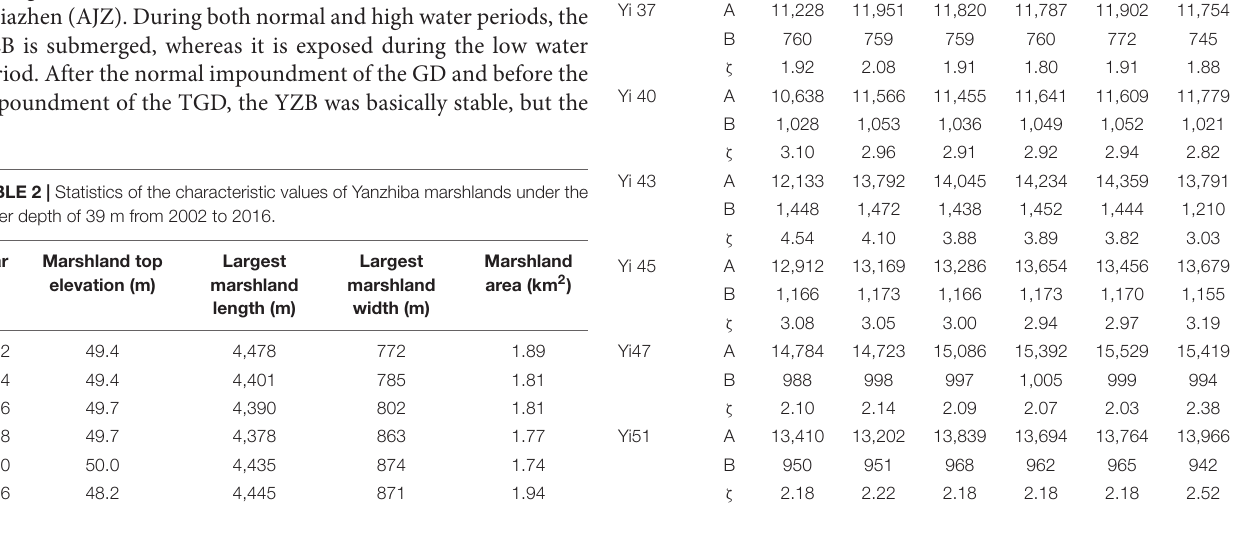
TABLE 3 | Statistics of some cross-section elements of the Yichang reach under the water depth of 43.3 m. Cross-